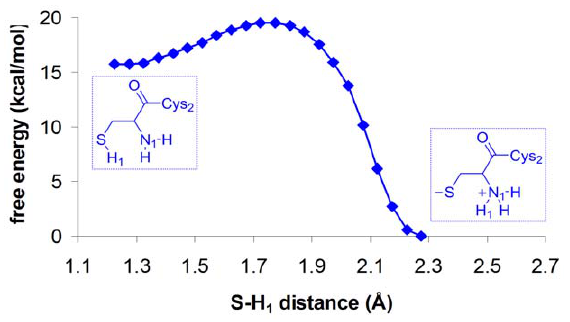
Figure 3. Free energy profile for Cys2 internal proton transfer. Free energy profile along S, H 1 distance as obtained from umbrella sampling calculations and WHAM.